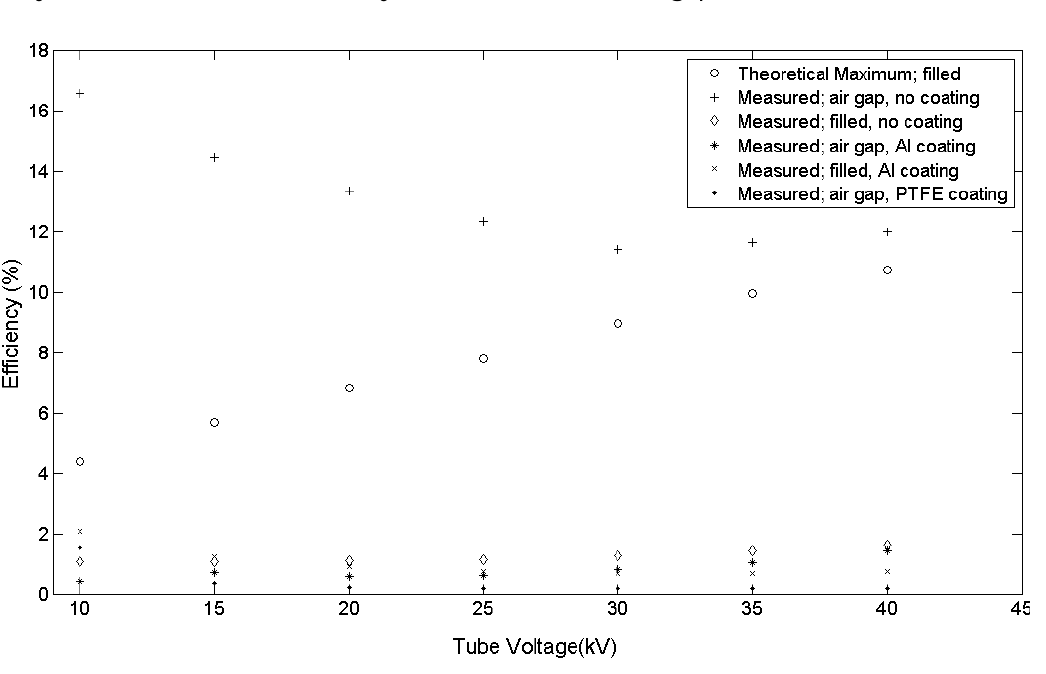
Figure 9. Anthracene increased efficiency from improved crystal growth and fiber configuration. The effect of coatings on fiber efficiency shows aluminum and PTFE thin films yield near the same efficiency with or without an air